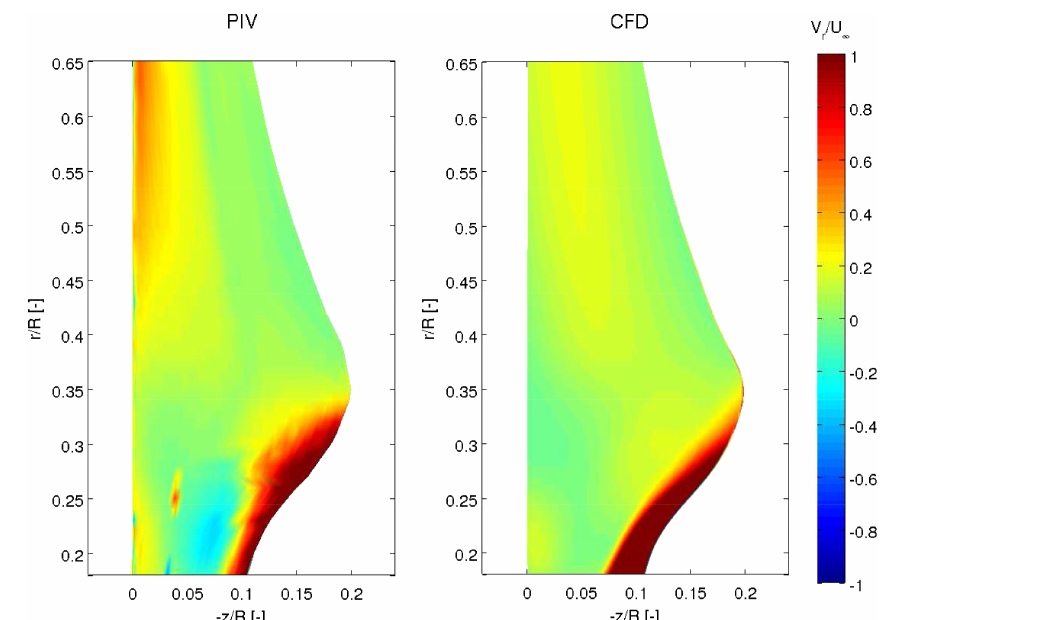
Figure 10. Experimental and numerical results of radial velocity component 10mm off the blade suction